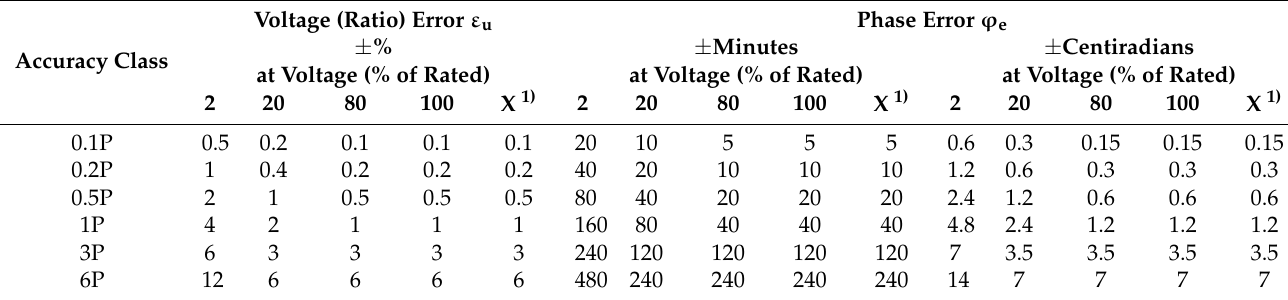
Table 2. Protection class accuracy requirements as per IEC 61869-11